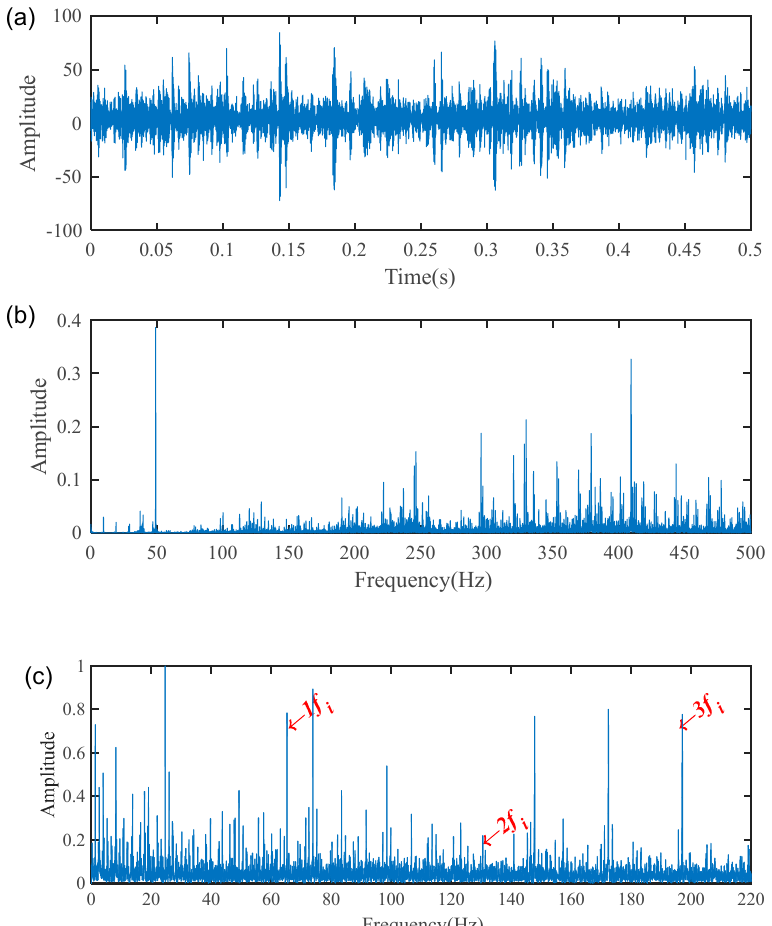
Figure 5. Vibration signal of the 2-stage helical gearbox bearing with inner race fault: ( a ) waveform; ( b ) spectrum; ( c ) envelope spectrum.